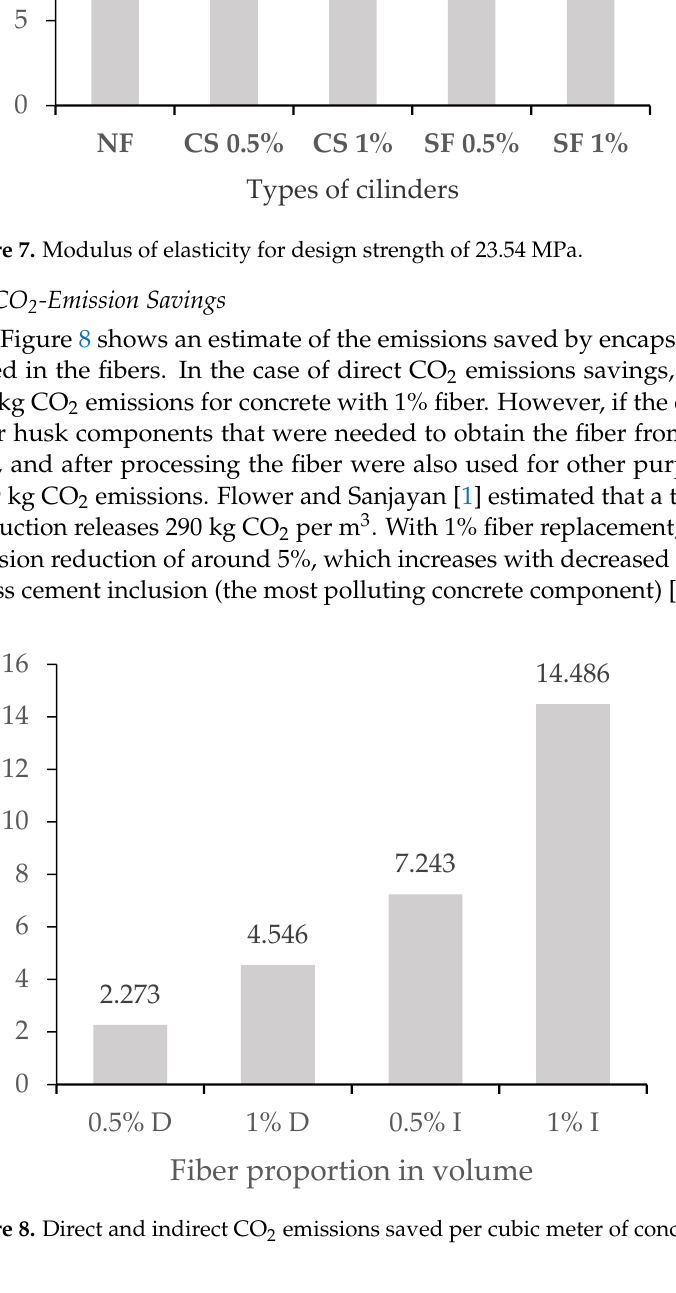
Figure 8. Direct and indirect CO 2 emissions saved per cubic meter of concrete. 4. Conclusions Experiments with coconut-fiber composite concrete were performed by changing the fiber treatment, fiber volume proportion, mix design, and cylinder ages. The maximum values of the studied properties can be observed in a combination of NaOH-treated fibers, with lower design strength, and lower fiber volume proportion. Fiber-matrix adhesion played a key role in improving the performance of CS cylinders compared with SF cylin- ders. Fiber inclusion in concrete mixes was a feasible strategy to reduce greenhouse-gas emissions during concrete manufacturing, owing to the acceptable mechanical properties